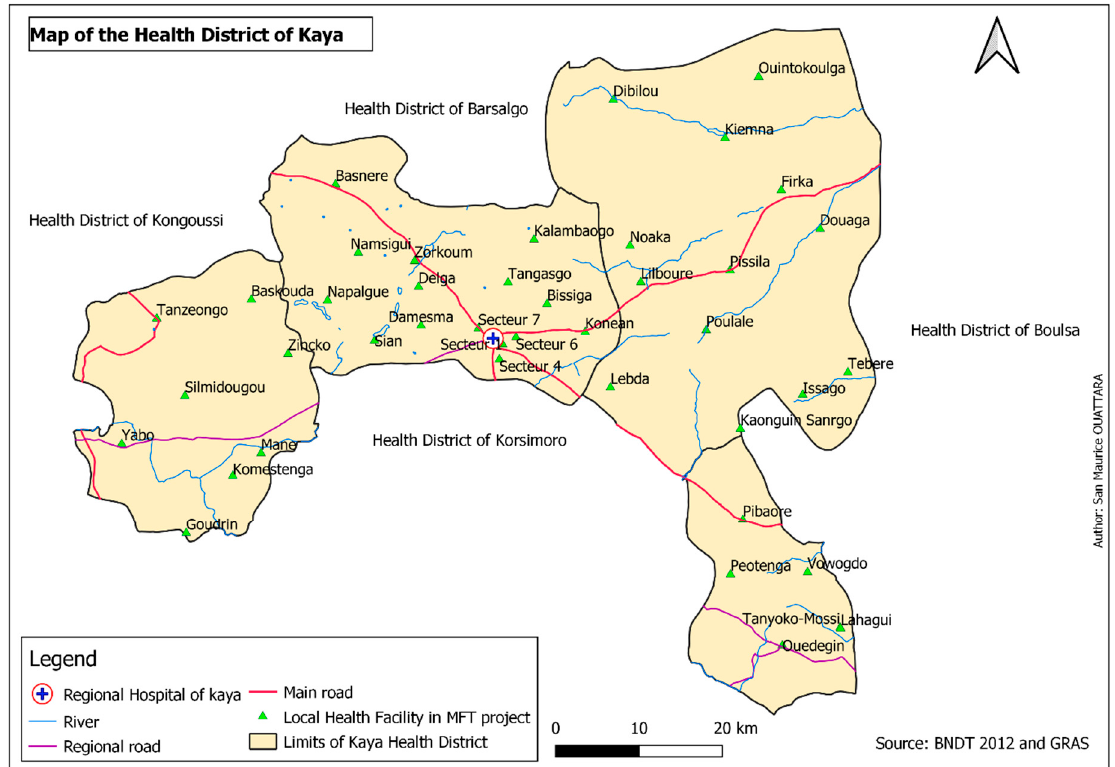
Figure 2. Map of health facilities in the district of Kaya included in this pilot study, 2020.